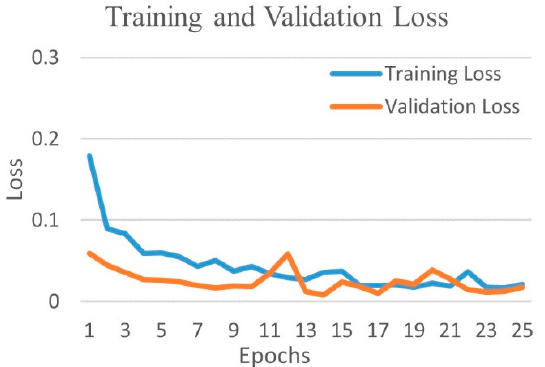
Figure 14. Training and validation loss of best performing VGG16 model for COVID-19 and tuberculosis class.